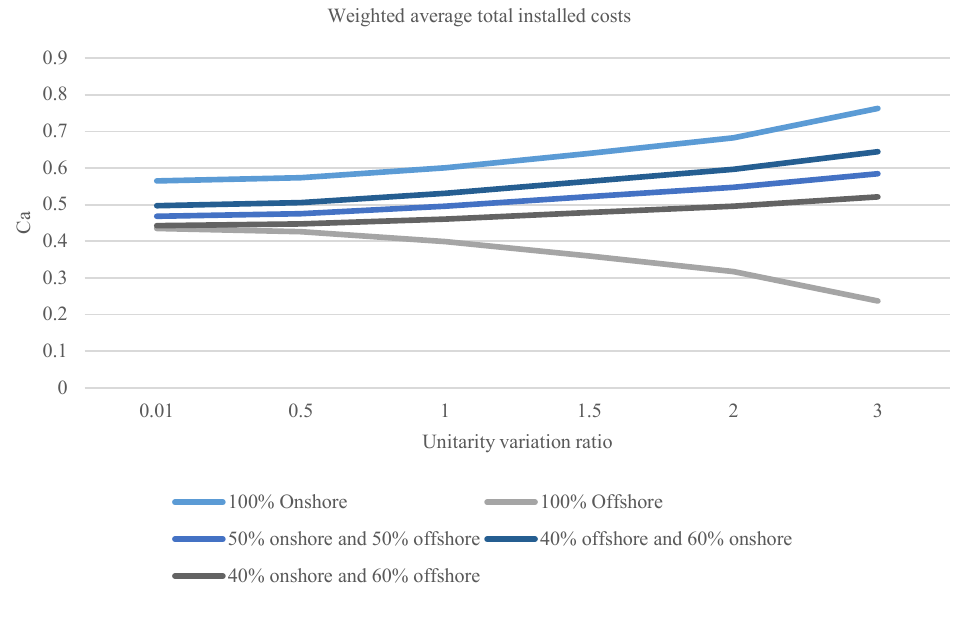
Fig. 5(b). Sensitivity analysis of Weighted average total installed costs.